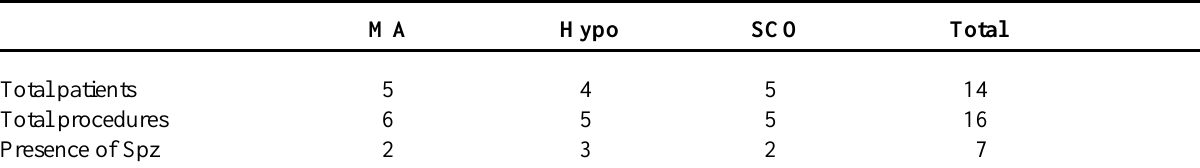
Table 1 – Sperm retrieval biopsy results according to histopathological